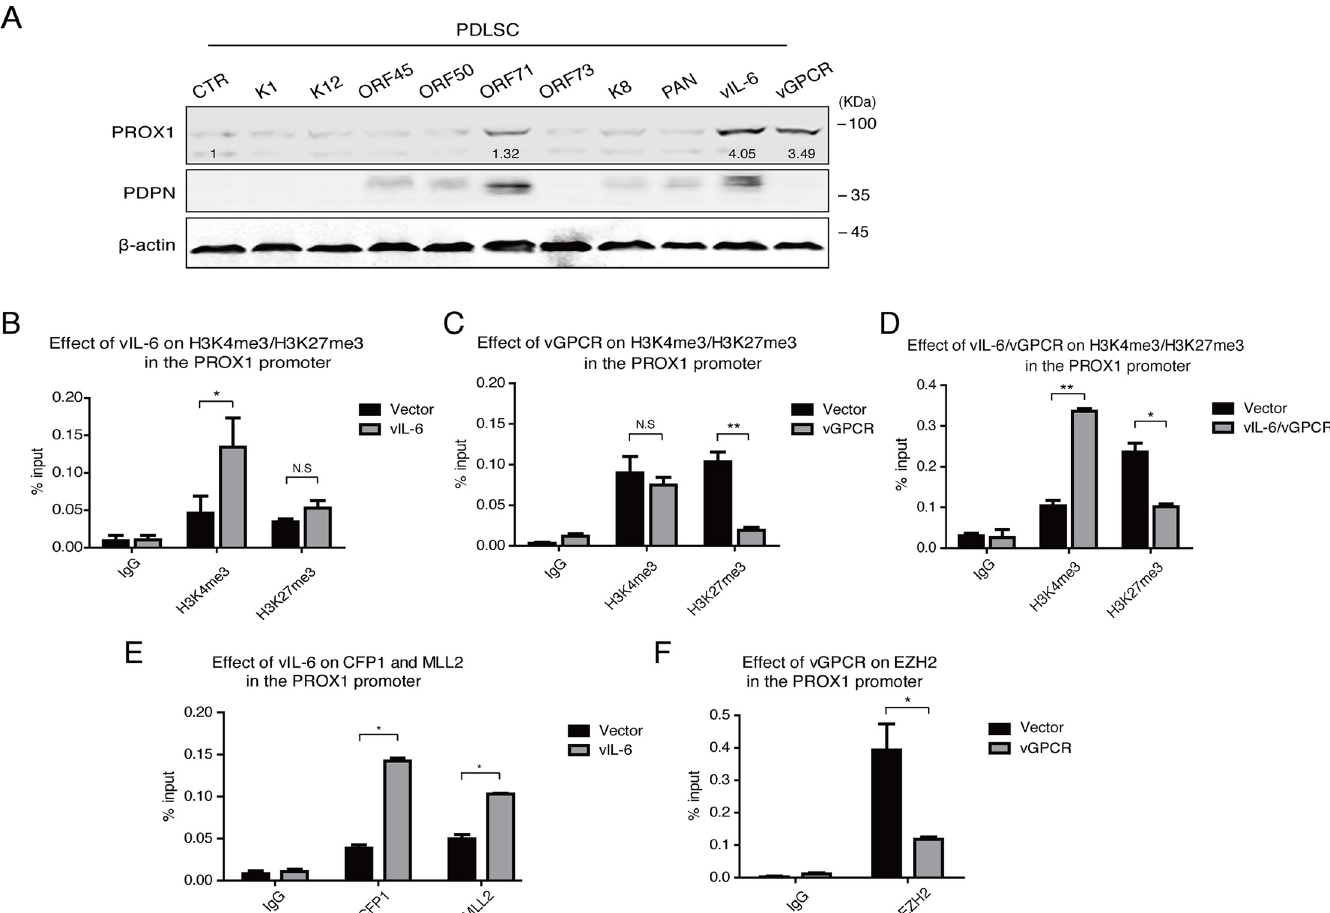
Fig 5. Identification of KSHV components that are responsible for the epigenetic regulation of PROX1 gene expression. (A) PDLSCs were transfected with a class of viral gene expression vectors, including K1, K12, ORF45, ORF50, ORF71, ORF73, K8, PAN, vIL-6, and vGPCR. The effects of these viral components on PROX1 expression were assayed by Western blot. ChIP assays were performed with PDLSCs ectopically expressing vIL-6 (B), vGPCR (C), or both (D) for their effects on H3K4 and H3K27 trimethylation in the PROX1 promoter. The effects of expression of vIL-6 (E) and vGPCR (F) on CFP1, MLL2, and EZH2 in the PROX1 gene were examined by ChIP assays. Error bars represent SD. Statistics analysis was performed using the one-way ANOVA test. P-value < 0.05 was considered significant ( � P < 0.05, �� P < 0.01 and ��� P < 0.001) and N.S represented no significance.